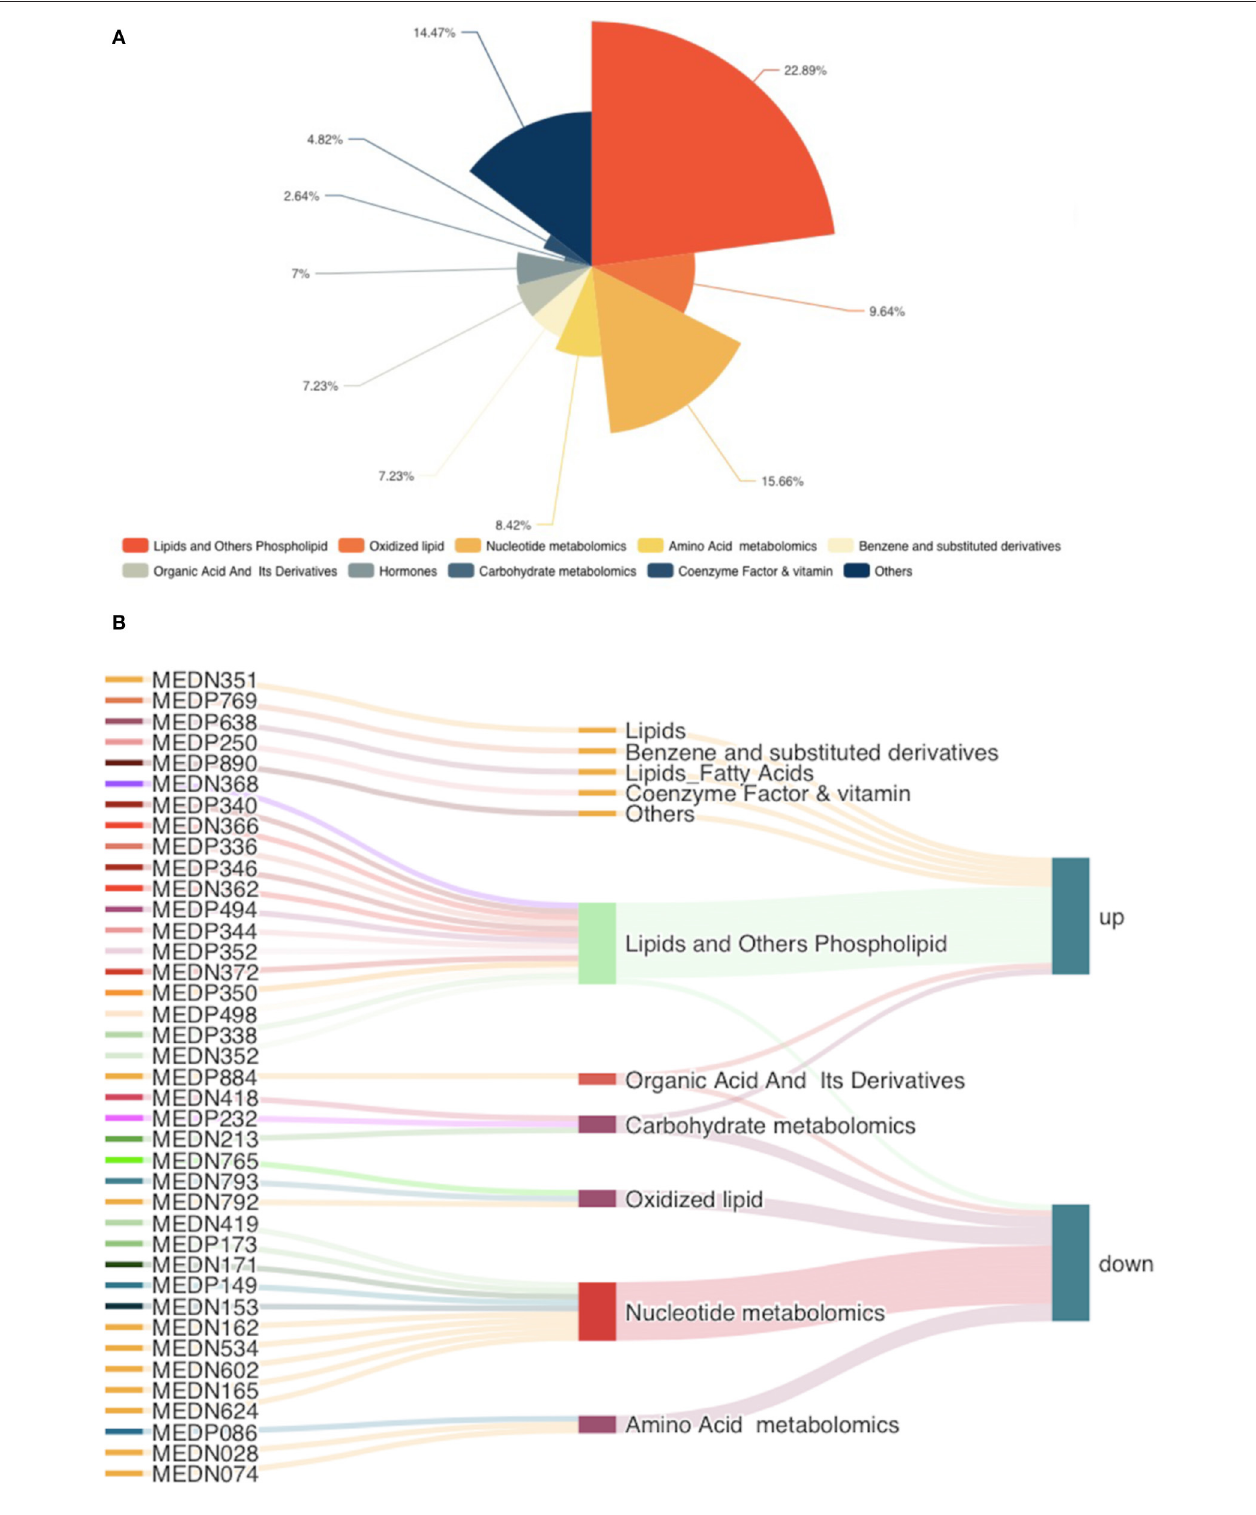
FIGURE 2 | The classes of differentially accumulated metabolites. (A) Pie charts showing different classes of total DAMs, different colors indicate different classes. (B) The top 20 up-regulated and down-regulated DAMs were illustrated in the Sankey diagram.